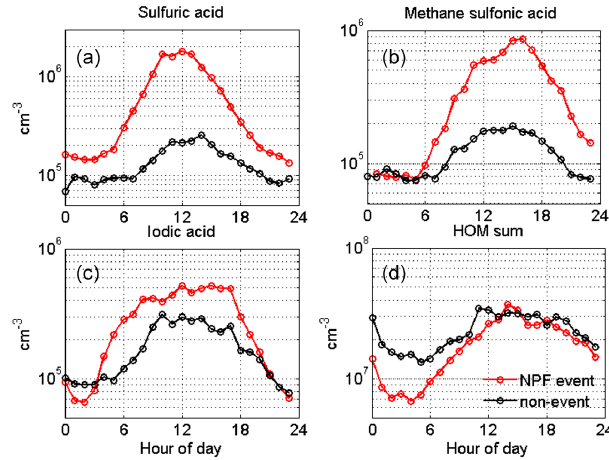
Figure 9. Aerosol precursor gases at SMEAR I during NPF (red, n = 33) and non-event days (black, n = 75). The data are an hourly median